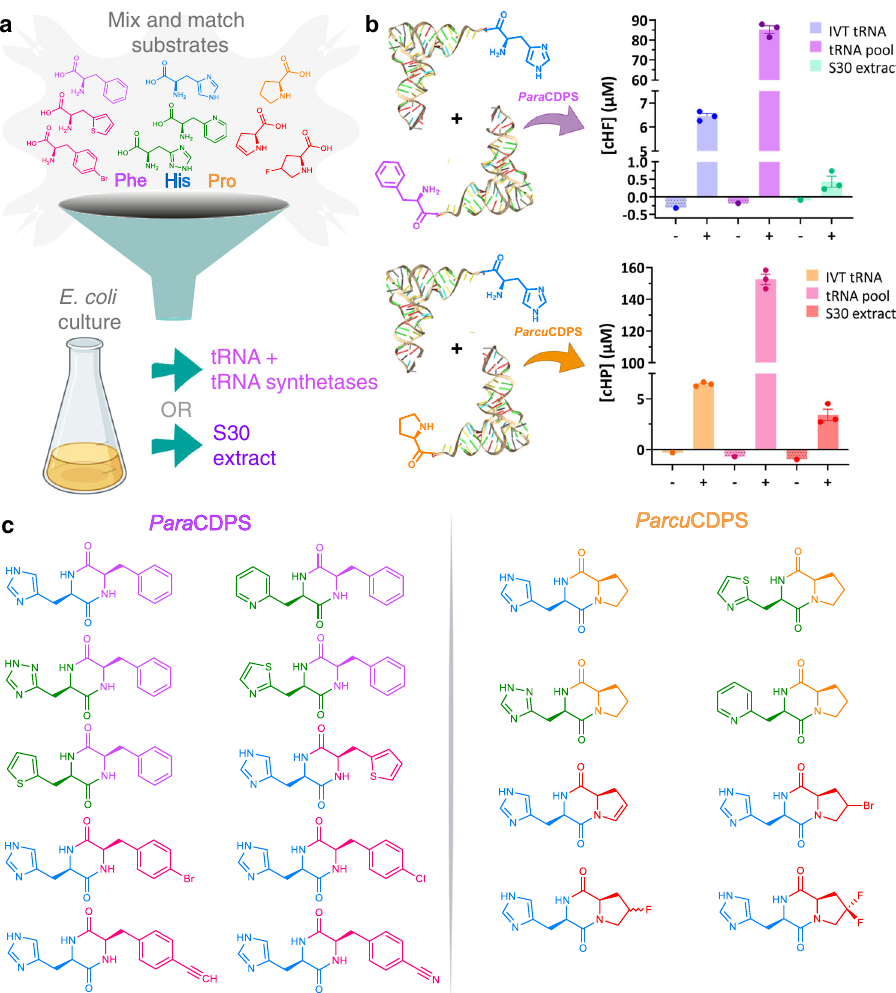
Fig. 2 Production of novel cyclodipeptides using Para CDPS and Parcu CDPS. a Cartoon schematic depicting possible substrates for each CDPS studied herein. The tRNA structure of the aminoacylated tRNA is from the PDB – 1EHZ. b Quanti fi cation of CDP production by LC-MS using a standard calibration curve. Data is shown as single point in triplicate with error bars plotting the standard error of the mean (SEM). Measurements were taken from distinct samples. The presence ( + ) and absence ( − ) of CDPS is displayed for each source of tRNA: in vitro transcribed (IVT) tRNA; tRNA pool and S30 extract. It is evident that the tRNA pool is a far superior method of producing CDP for both CDPSs. c Generation of a cyclic dipeptide library using Para CDPS and Parcu CDPS using non-canonical amino acids: histidine derivatives are shown in green; phenylalanine derivatives in pink and proline derivatives in